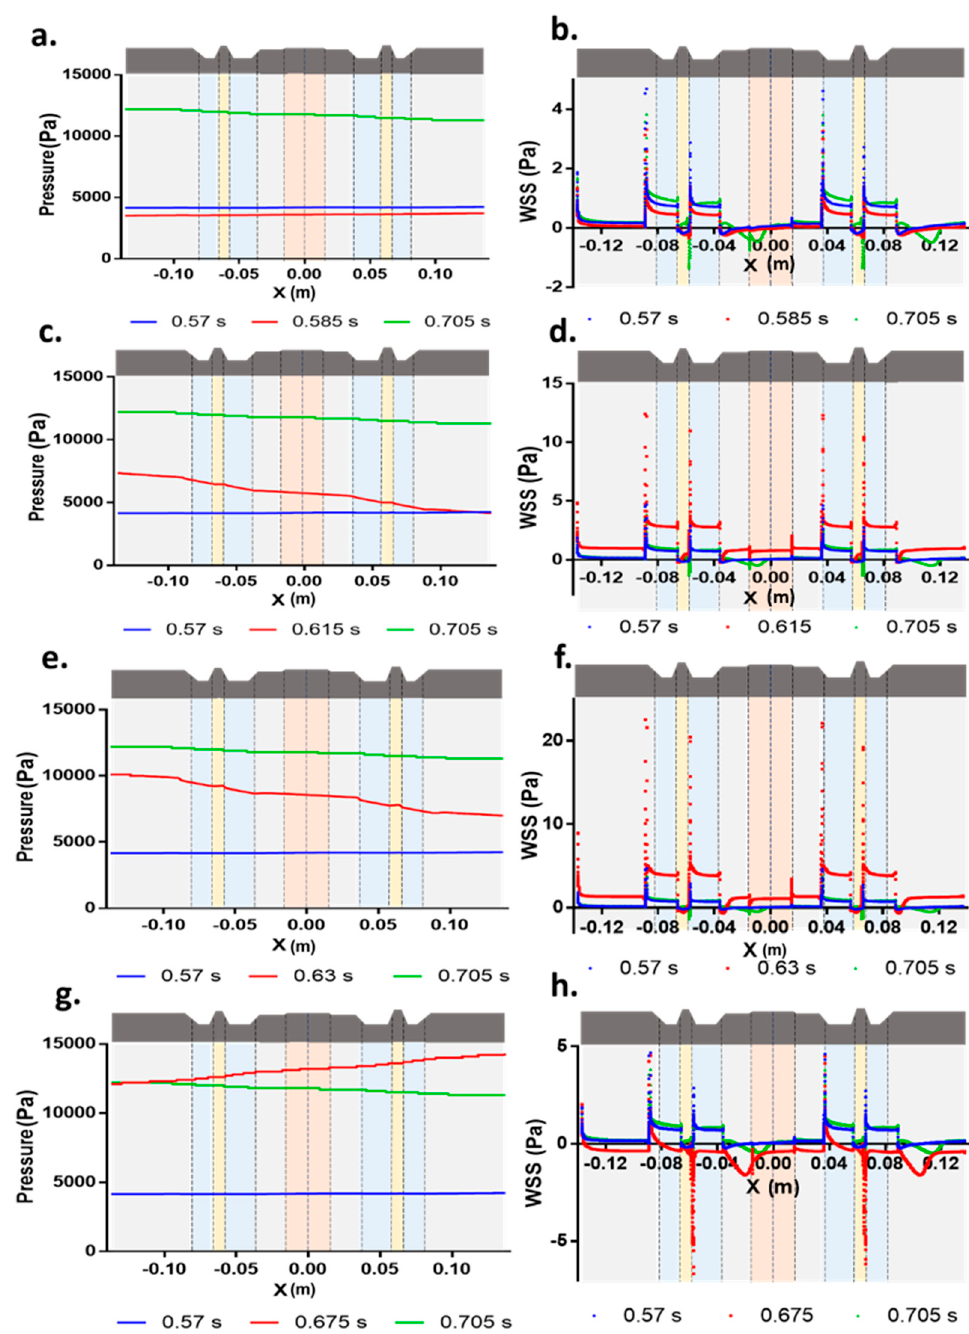
Figure 12. Pressure and Wall Shear Stress distributions along the global geometry of the computational domain for Phase 1. Initial and final time steps for each phase are included as a comparison reference for the chosen time steps on both stages. ( a ) Pressure and ( b ) Wall Shear Stress for t = 0.585. ( c ) Pressure and ( d ) Wall Shear Stress for t = 0.615. ( e ) Pressure and ( f ) Wall Shear Stress for t = 0.63. ( g ) Pressure and ( h ) Wall Shear Stress for t = 0.675.